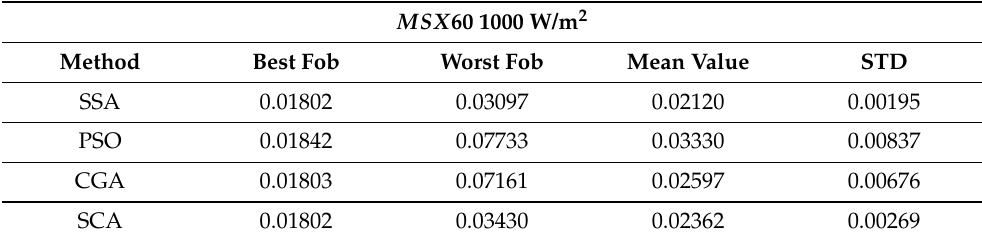
Table 8. Results obtained for the MSX 60 PV panel under a 1000 W/m 2 irradiance level.